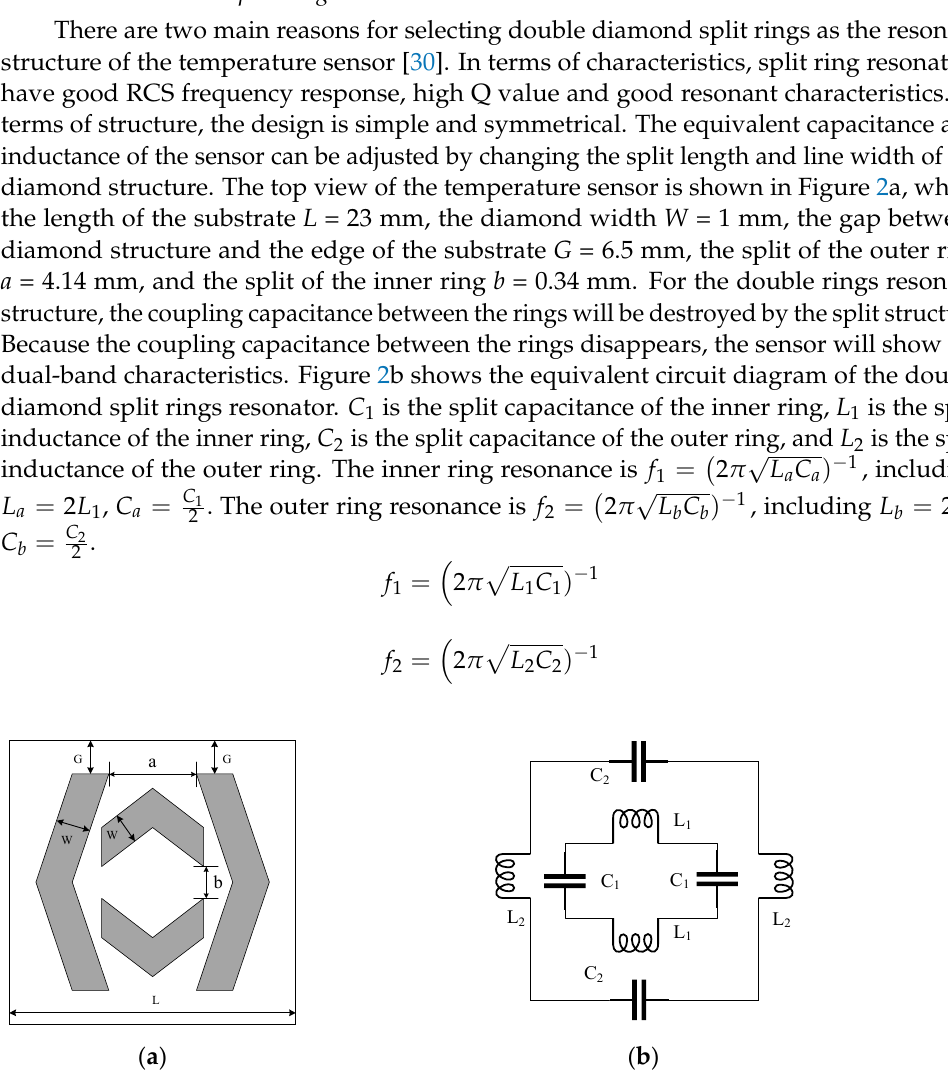
Figure 2. ( a ) Top view of temperature sensor. ( b ) Equivalent circuit diagram of double diamond split rings resonator.